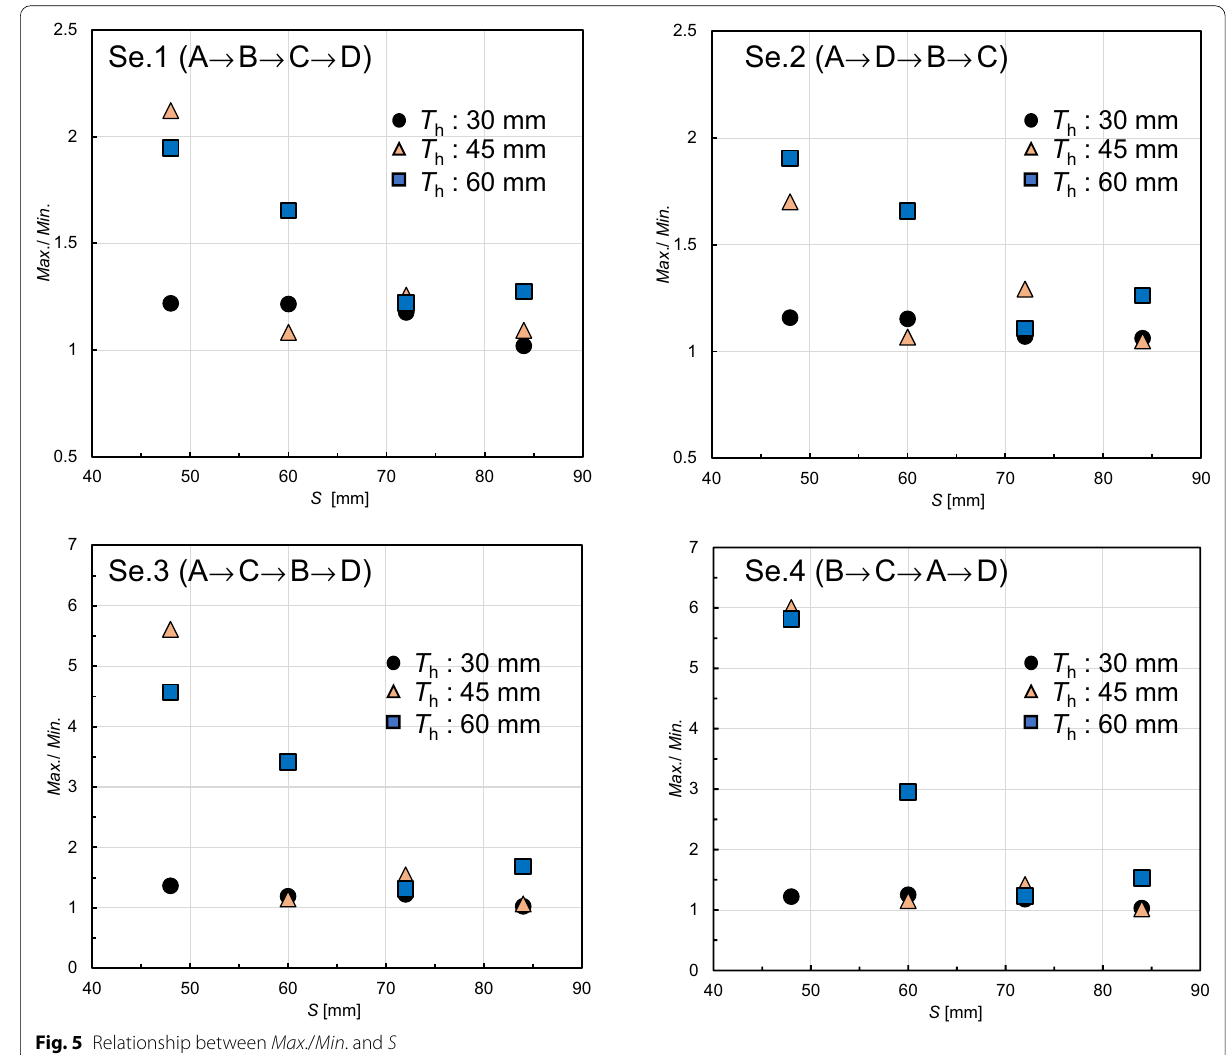
Fig. 5 Relationship between Max ./ Min . and S